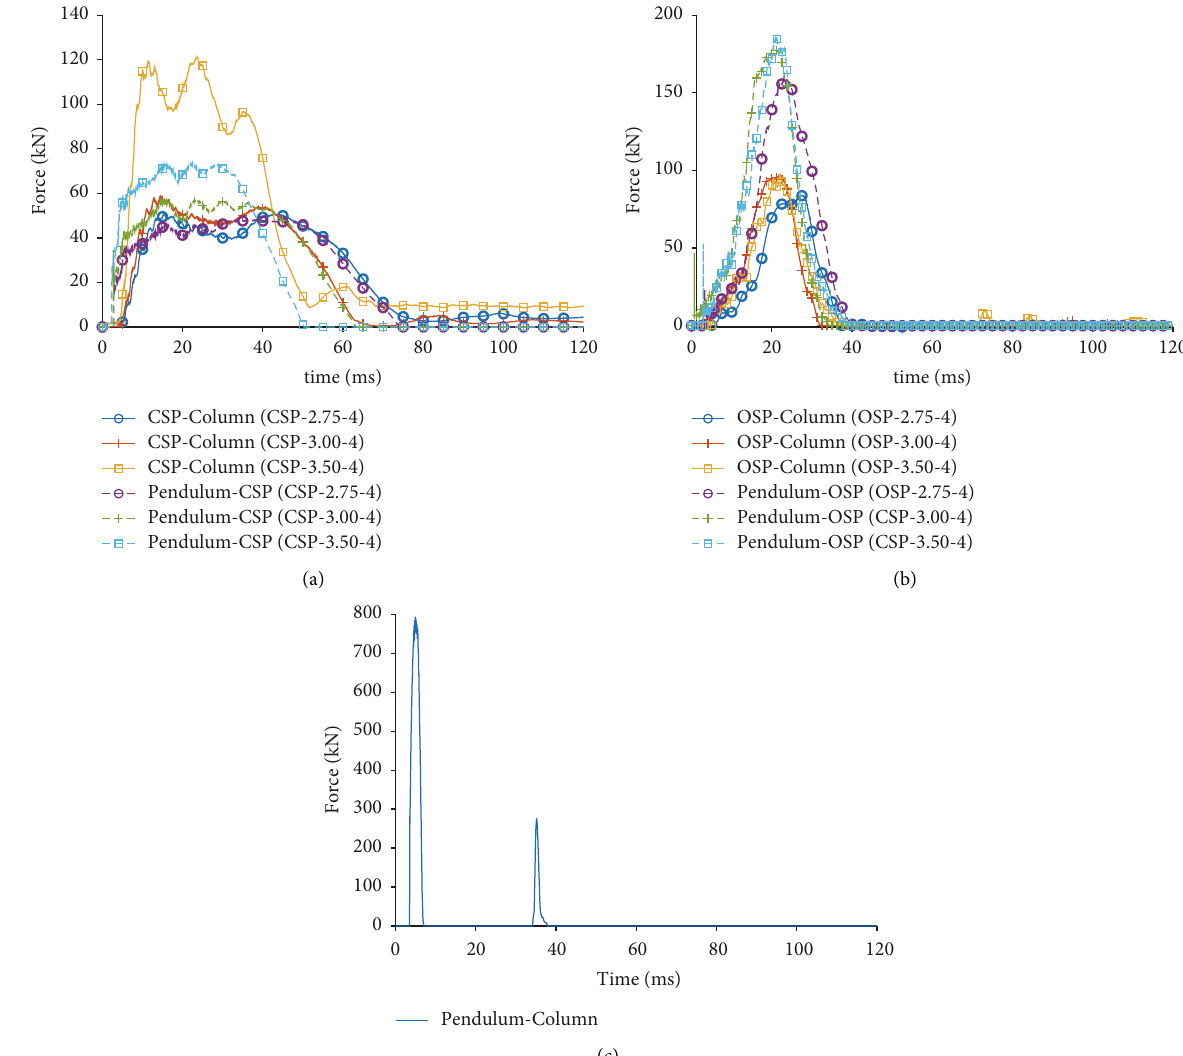
Figure 6: Time history curve of lateral impact force. (a) CSP; (b) OSP; (c)